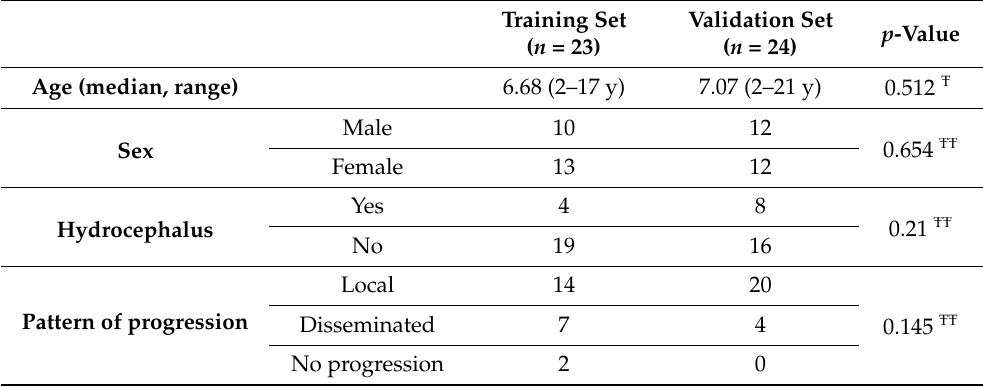
Table 1. DIPG tumor cohorts.